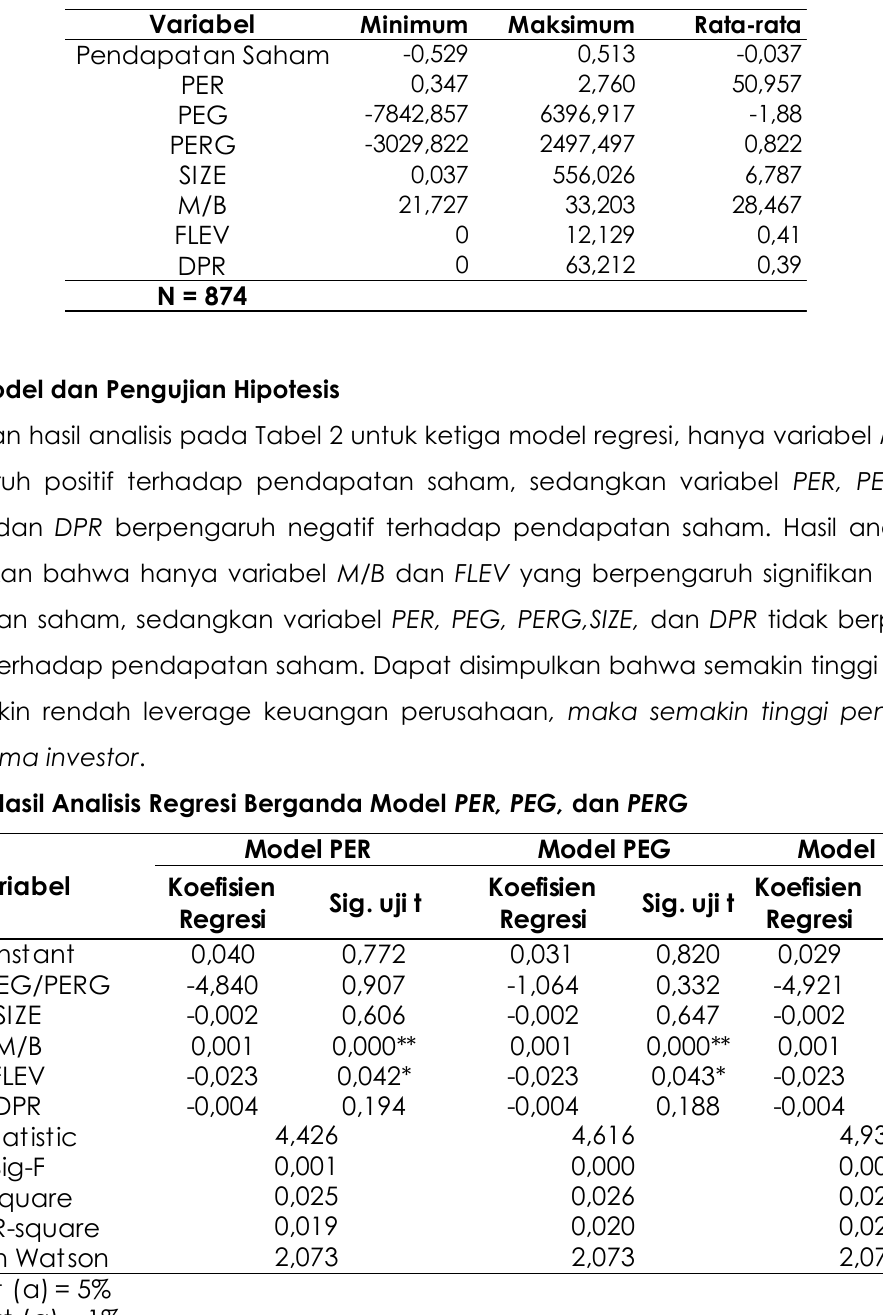
Tabel 1. Statistik Deskriptif Variabel Penelitian